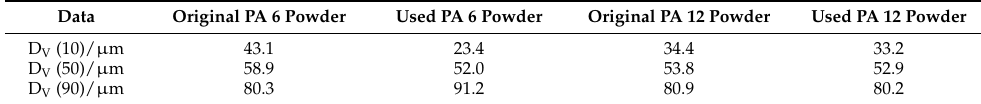
Figure 1. Differences in the morphology of original and used PA 6 and PA 12 powders. Reprinted with permission from ref. [14] copyright 2018 Elsevier. SEM images of ( a ) PA6, Original powder (100 μ m), ( b ) PA6, Used powder (50 μ m), ( c ) PA6, Used powder (20 μ m), ( d ) PA12, Original powder (100 μ m), ( e ) PA12, Used powder (50 μ m), ( f ) PA12, Used powder (20 μ m). Table 1. Particle size distribution of the two powders after a single print cycle [14].